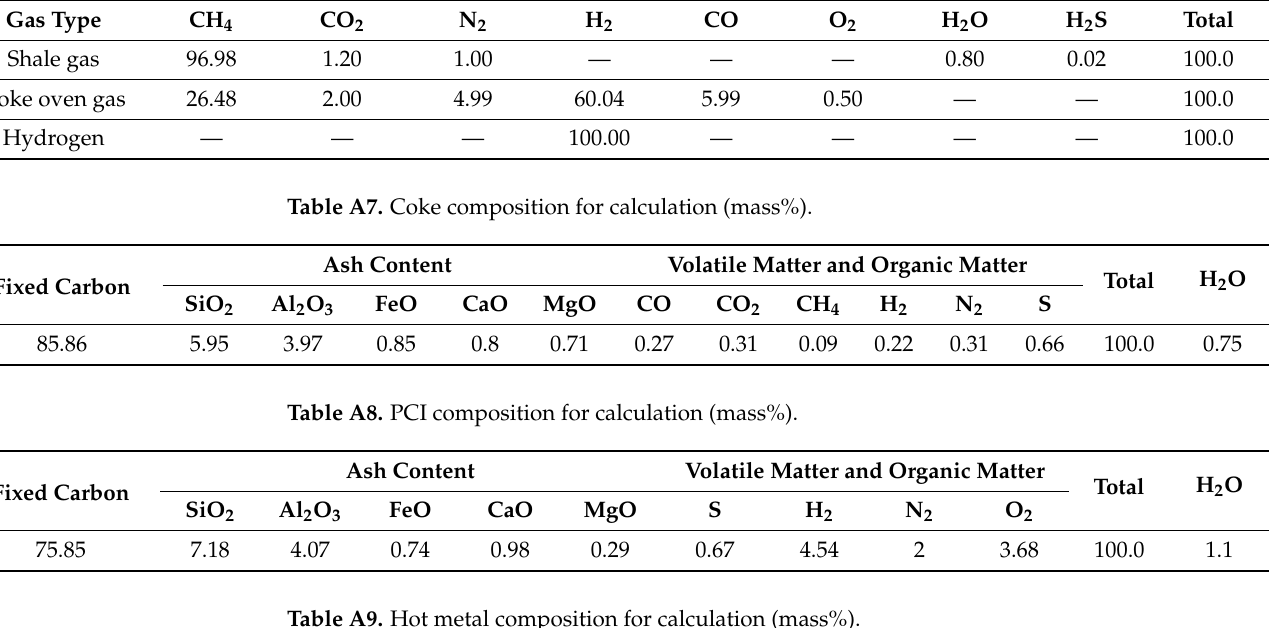
Table A9. Hot metal composition for calculation (mass%).